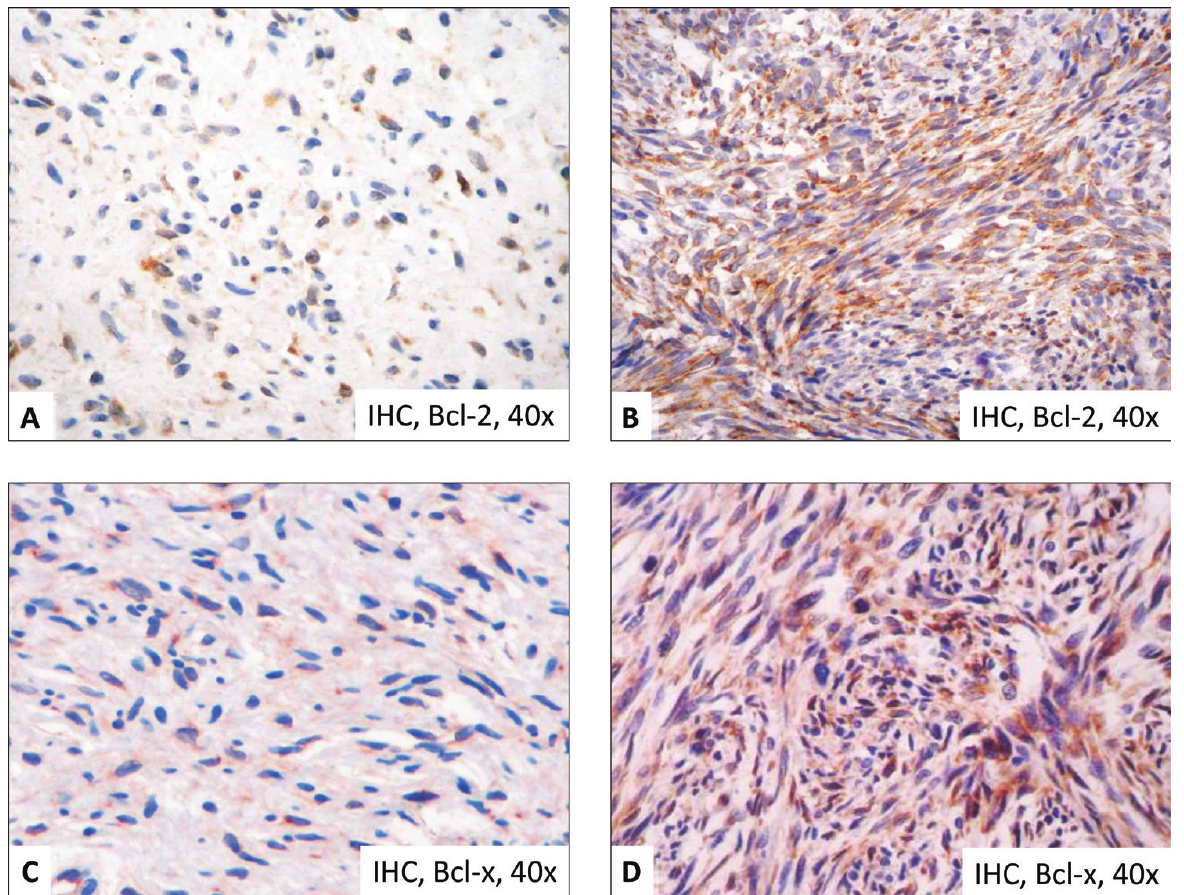
Fig. 1 - A . Neurofibroma showing cytoplasmic immunostaining for Bcl-2; B . MPNST with cytoplasmic immunostaining for Bcl-2; C . Neurofibroma showing cytoplasmic immunostaining for Bcl-x; D . MPNST with cytoplasmic immunostaining for